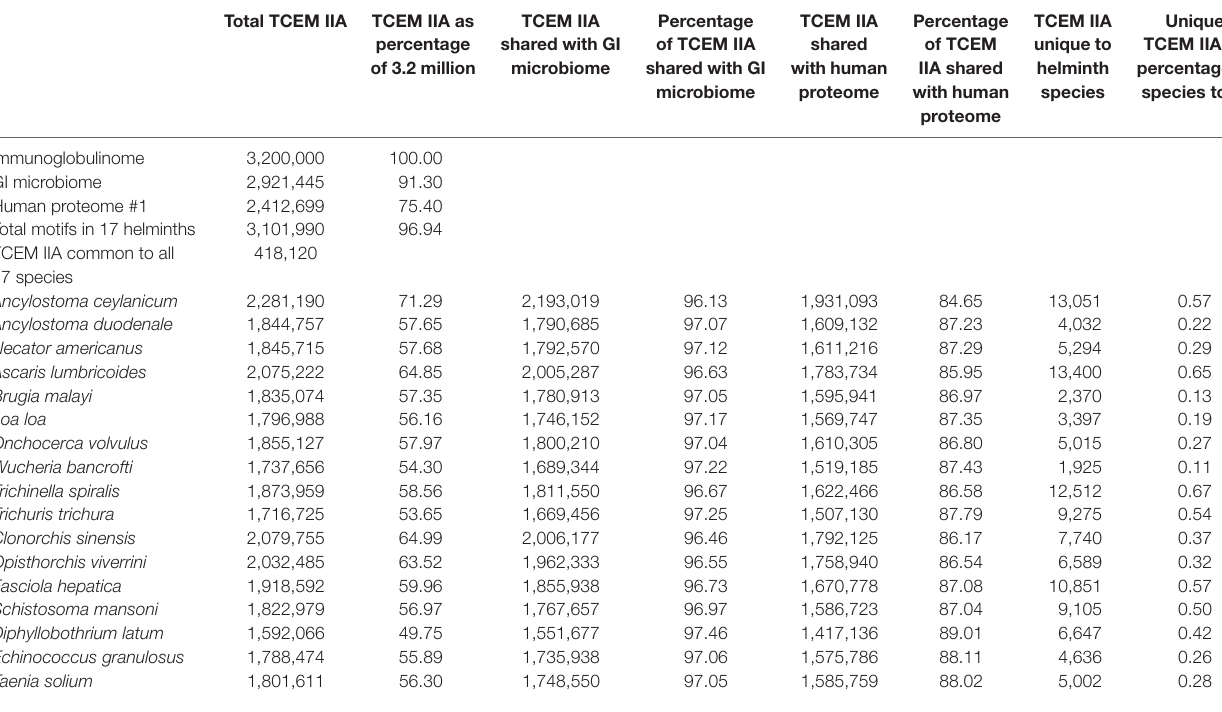
Table 2 | Sharing of total T-cell-exposed motif (TCEM) IIA between helminths, gastrointestinal microbiome, and human